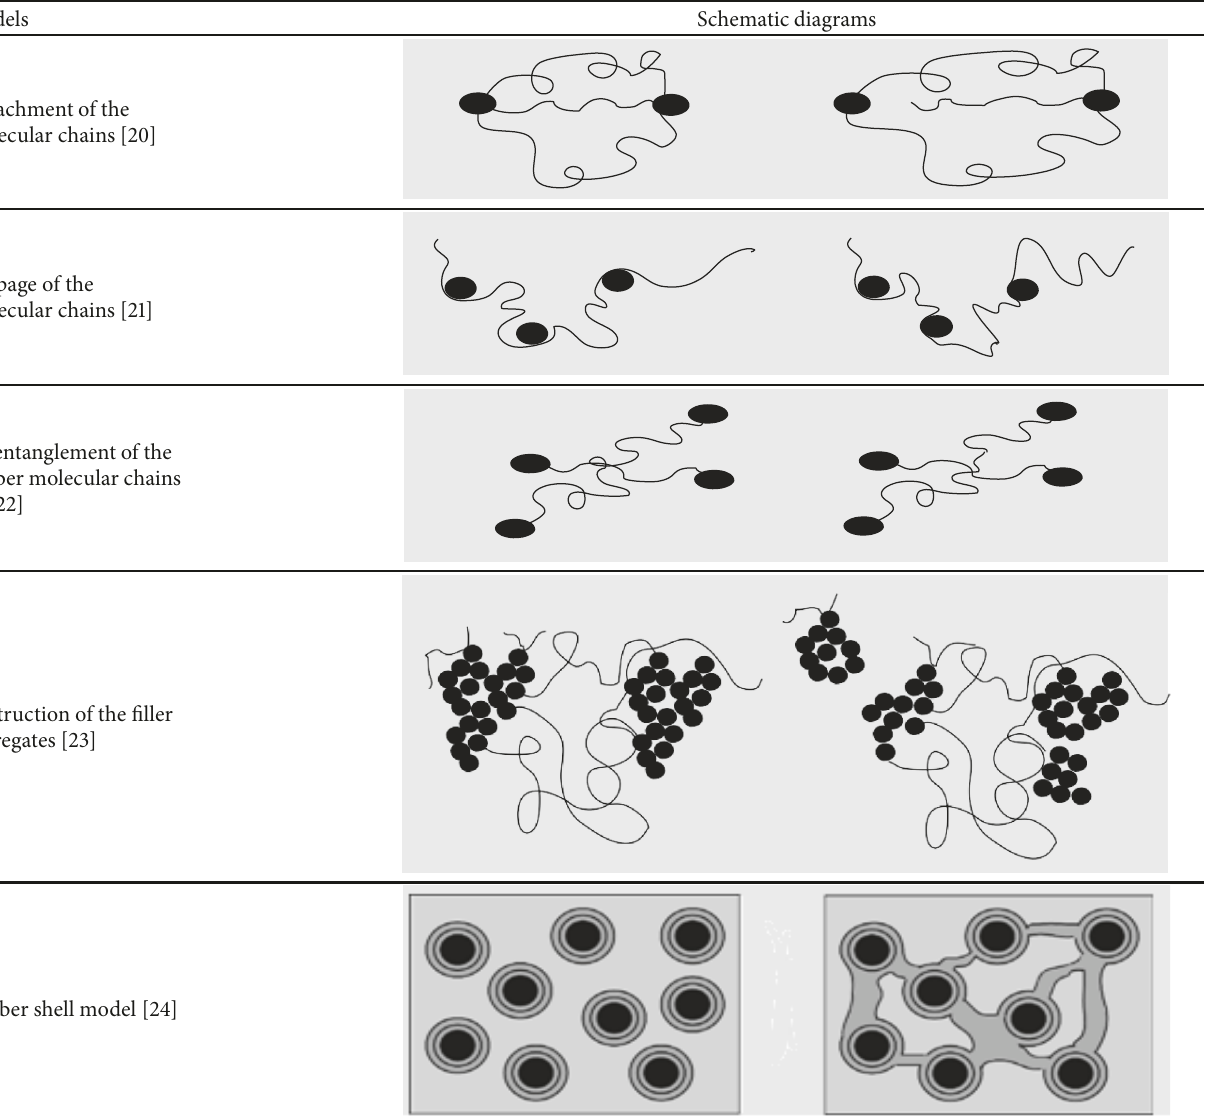
Table 1: Schematic diagrams of Mullins effect